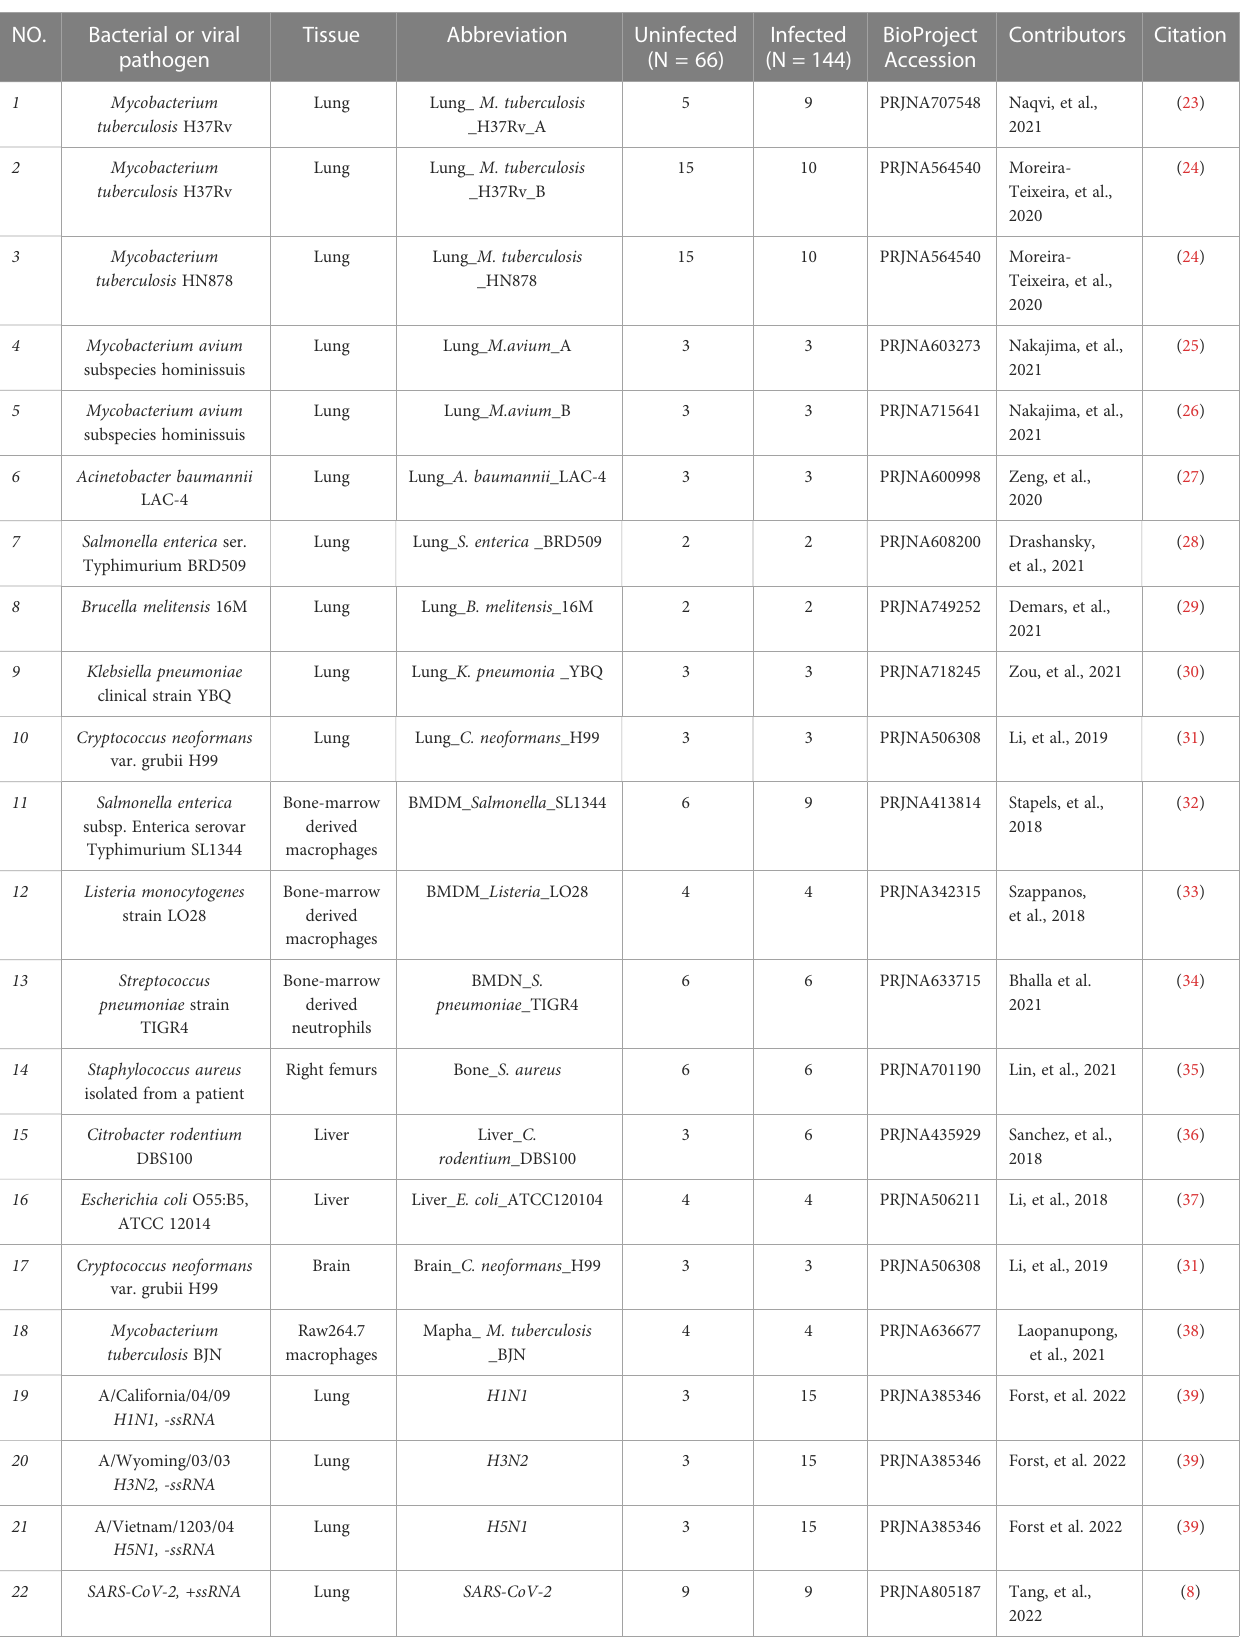
TABLE 1 Details of the GEO datasets included in the current